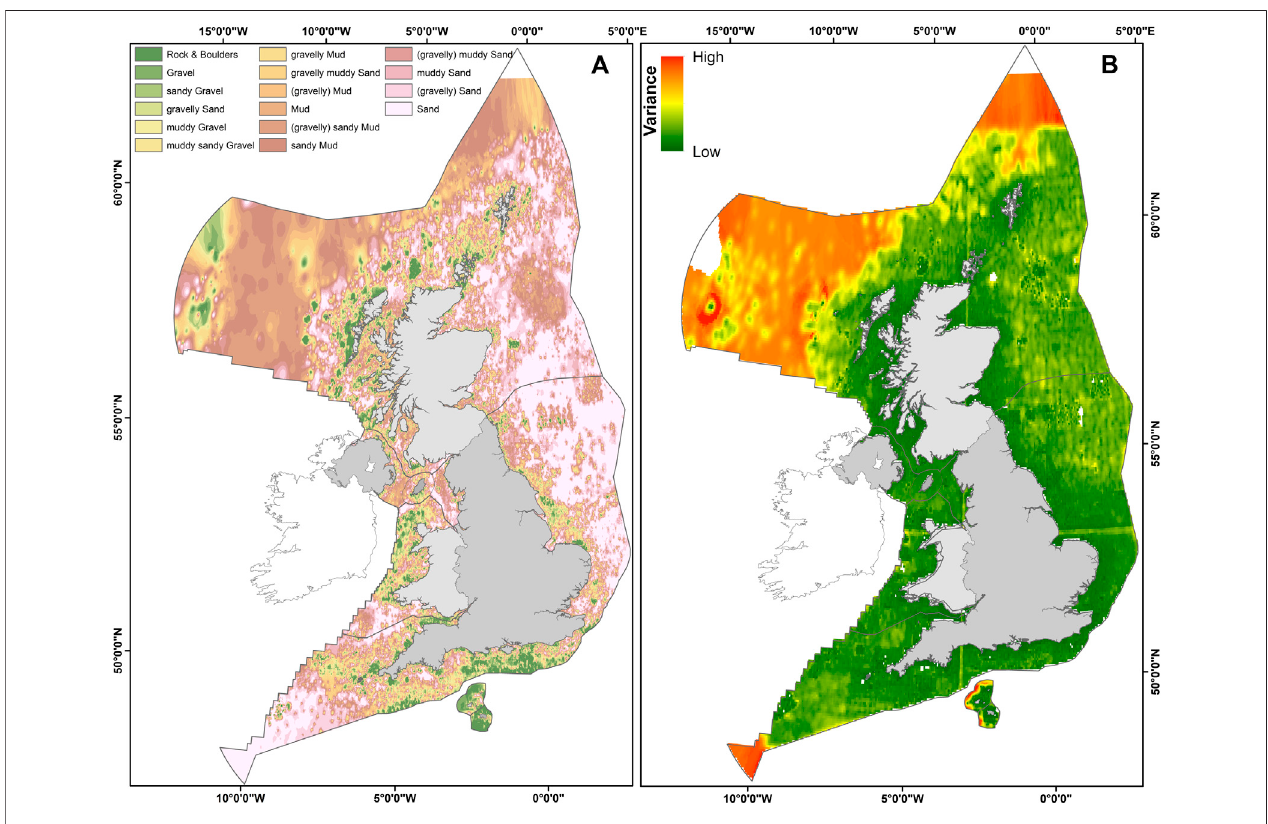
FIGURE2| BespokesedimentmapoftheUKEEZ (A) SpatialdistributionofsedimentacrosstheUKEEZillustratedbythe16Folkclasses(Kaskelaetal.,2019) (B) VarianceintheKriginganalysisasameasureofcon fi denceinthepredictionsofthesesedimentclasses:LowVariance:HighCon fi dence,HighVariance:Lowcon fi dence.